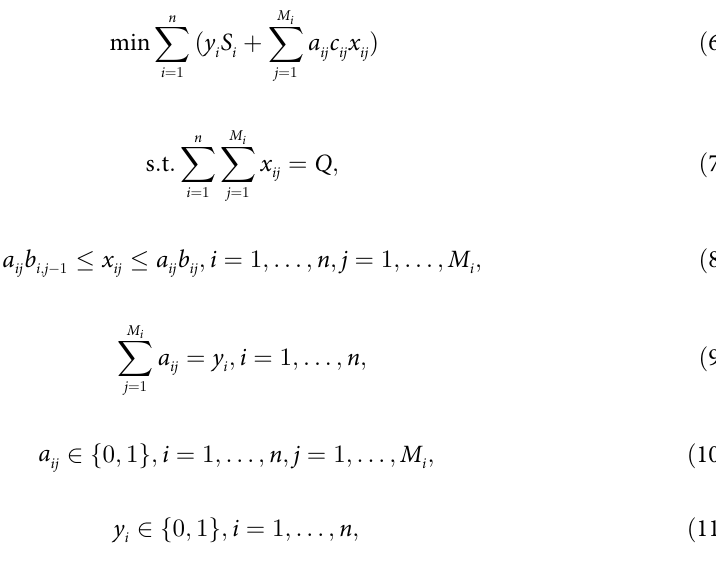
All-units discount case. The model for the all-units discount case is as follows.